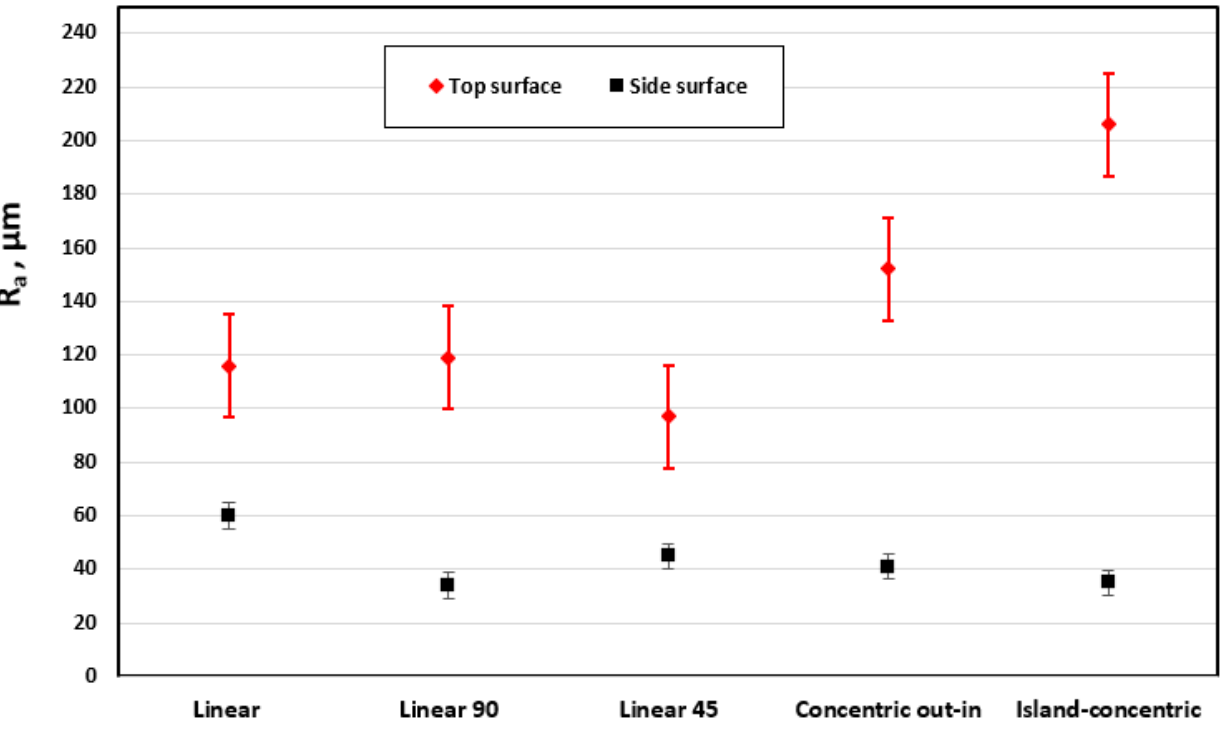
Figure 17. Top and side surface roughness of the printed sample using laser power of 95 W laser power and scanning speed of 200 mm/s.